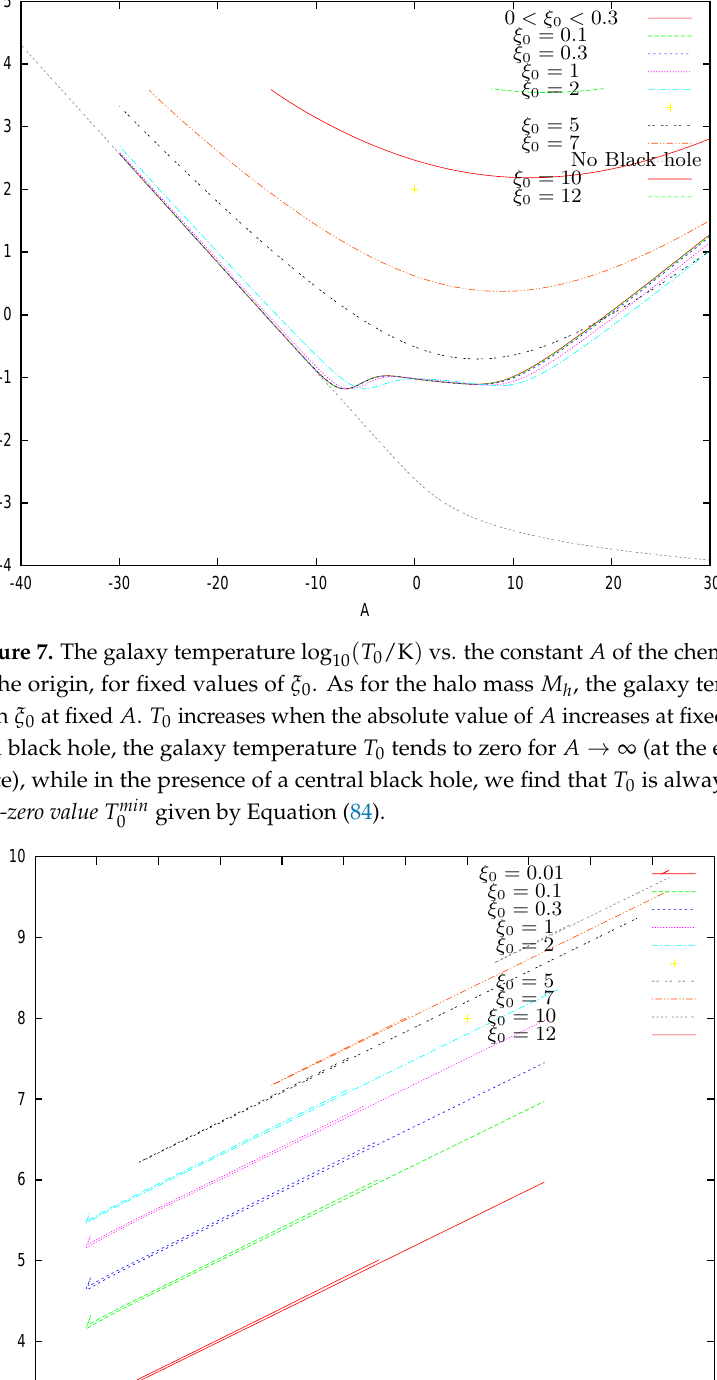
FIG. 8: The black hole mass log M BH vs. the halo mass log M h . The black hole mass M BH turns out to be a two-valued 10 10 function of M h . For each value of M h there are two values for M BH . These two values of M BH for a given M h are quite close to each other. This two-valued dependence on M h is a direct consequence of the dependence of M h on the central chemical potential behaviour characterized by the constant A as shown in Fig.